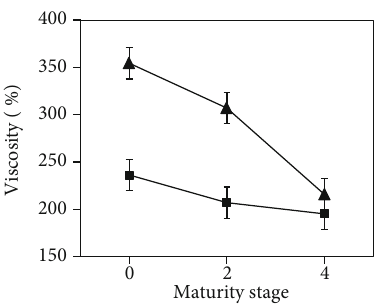
Figure 5: Viscosity of jams made from mango peel pectin extracted after 20min at di ff erent maturity stages (0, 2, and 4) at 37 kHz ( ▲ ) and 80kHz ( ■